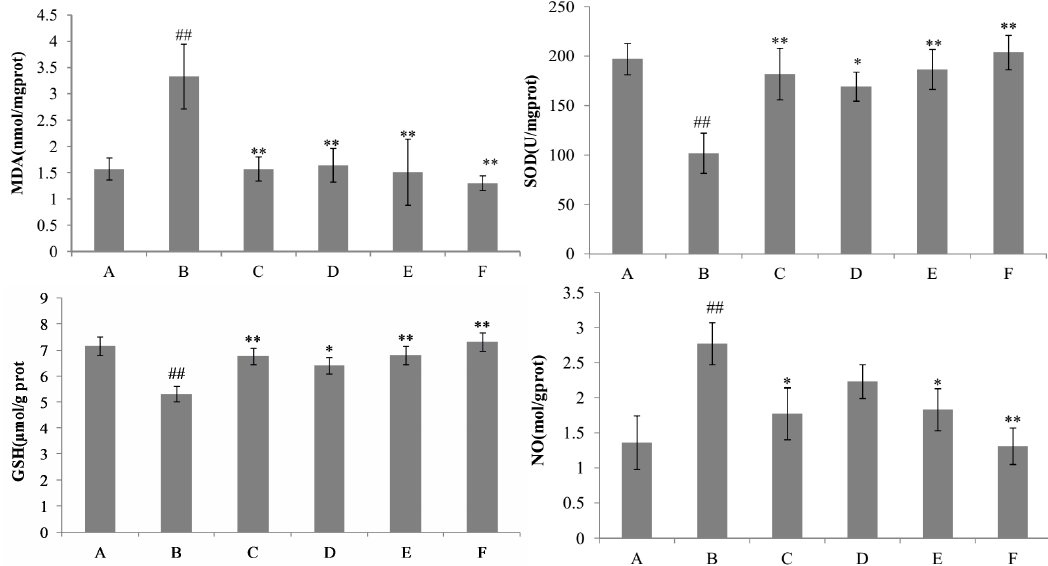
Figure 4. Effects of nicotiflorin on hepatic homogenate superoxide dismutase (SOD), malondialdehyde (MDA), glutathione (GSH), and nitric oxide (NO) in Con A-intoxicated mice. (A) Control group; (B) Con A-treated group; (C) Con A and DDB (150 mg/kg bw)-treated group; (D) Con A and nicotiflorin (25 mg/kg bw)-treated group; (E) Con A and nicotiflorin (50 mg/kg bw)-treated group; and (F) Con A and nicotiflorin (100 mg/kg bw)-treated group. Values are mean ± S.E.M., n = 10. ## p < 0.01 compared with the control group; * p < 0.05, ** p < 0.01 compared with the Con A group.